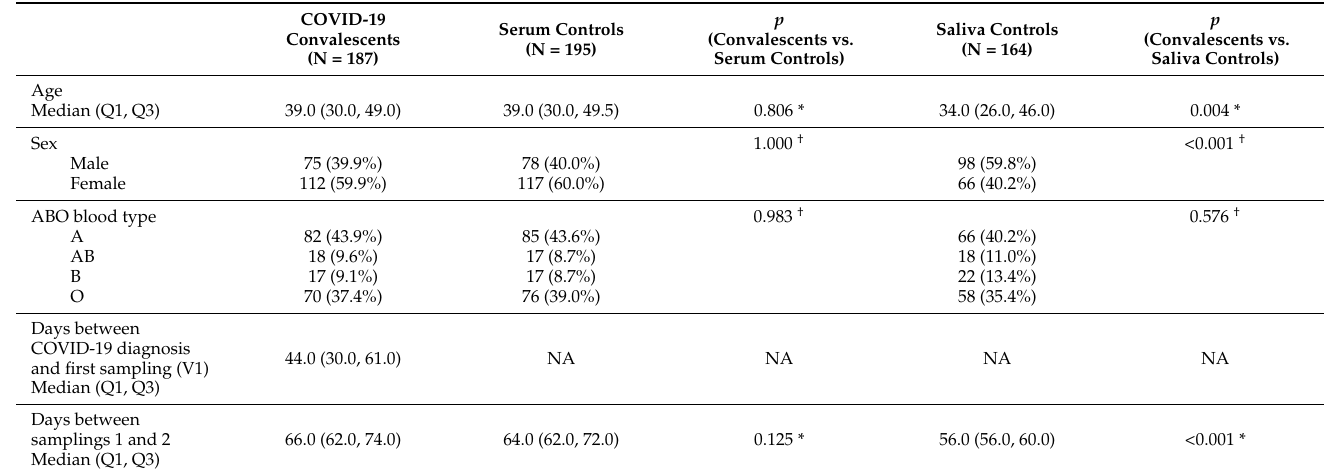
Table 1. Characteristics and demographics of study participants.